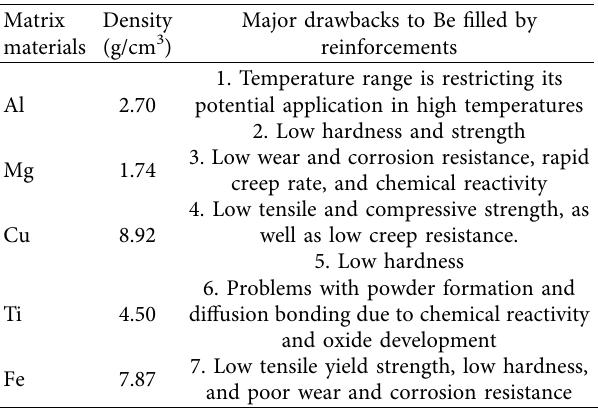
Table 1: Metallic matrix and their drawbacks [20,